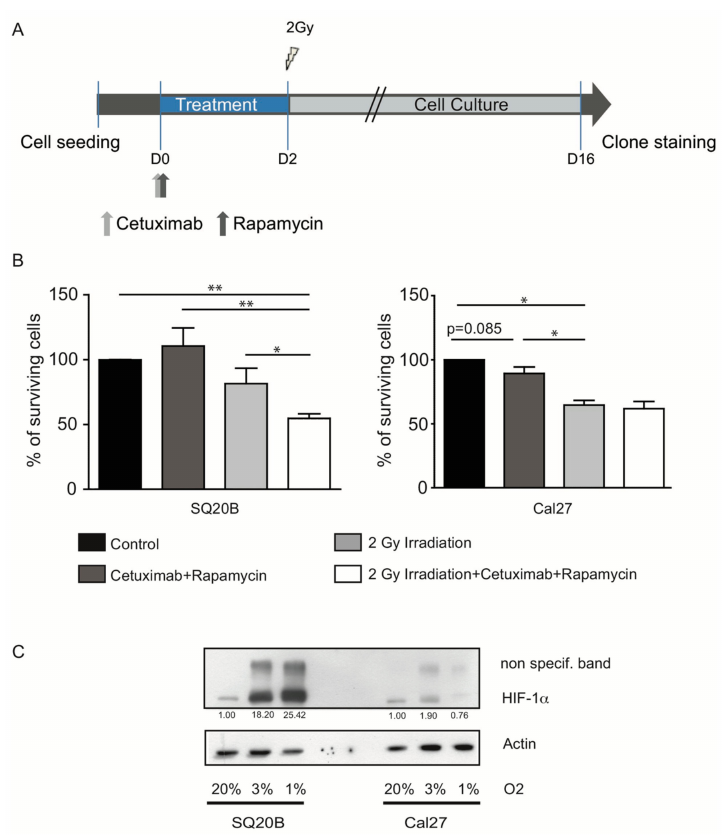
Figure 2. Epidermal Growth Factor Receptor (EGFR) / mTOR axis inhibition sensitizes SQ20B radioresistant cells. ( A ) In vitro treatment schedule of Cal27 and SQ20B cells. ( B ) Clonogenic survival assay of SQ20B and Cal27 cells after cetuximab / rapamycin treatment and 2Gy irradiation, delivered alone or in combination. Results from at least 3 independent experiments are shown. Error bars represent the standard deviation. (Kruskal–Wallis test and two-side Mann–Whitney: test; * p < 0.05; ** p < 0.01). ( C ) Hypoxia-Inducible Factor-1 (HIF-1 α ) expression at the protein level in SQ20B and Cal27 cell lines cultured in normoxic (20% O2) and hypoxic (3% and 1% O2) conditions. Signal quantifications (normalized to actin levels for each condition and expression level in normoxic conditions set to a value of 1) are